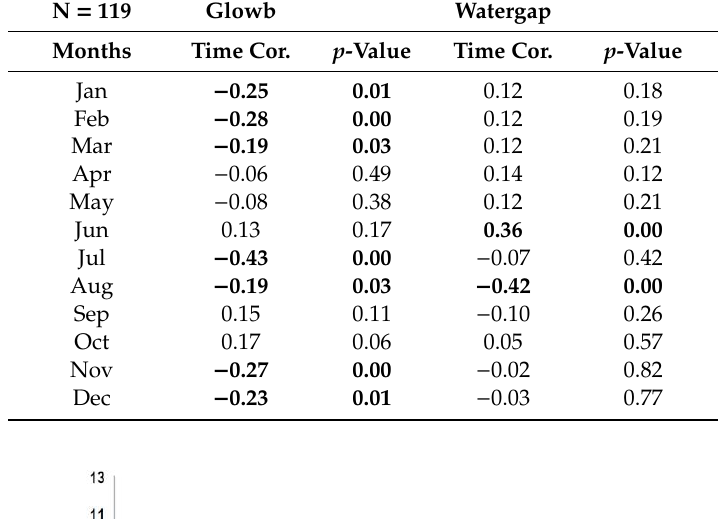
Table A3. Statistical significance of soil moisture trends per month in the NW-Ethiopian highlands, based on HadGEM2-ES rcp6 projection 1981–2100 and ISIMIP hydrological output, where bold values are significant. Temporal correlation indicating slope of regression line, where negative = drying, and p -value with respect to 119 degrees of freedom.